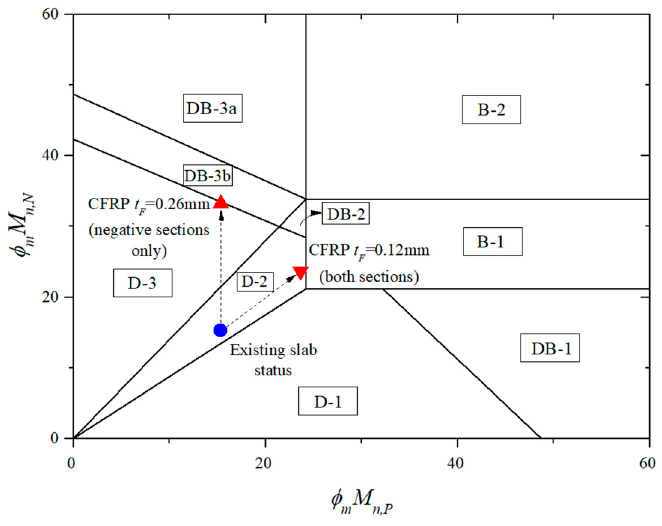
Figure 7. Failure limits for the flexural strengthened slab with CFRP considering ductile failure. Table 5. The strengthened slab capacities for the design example.